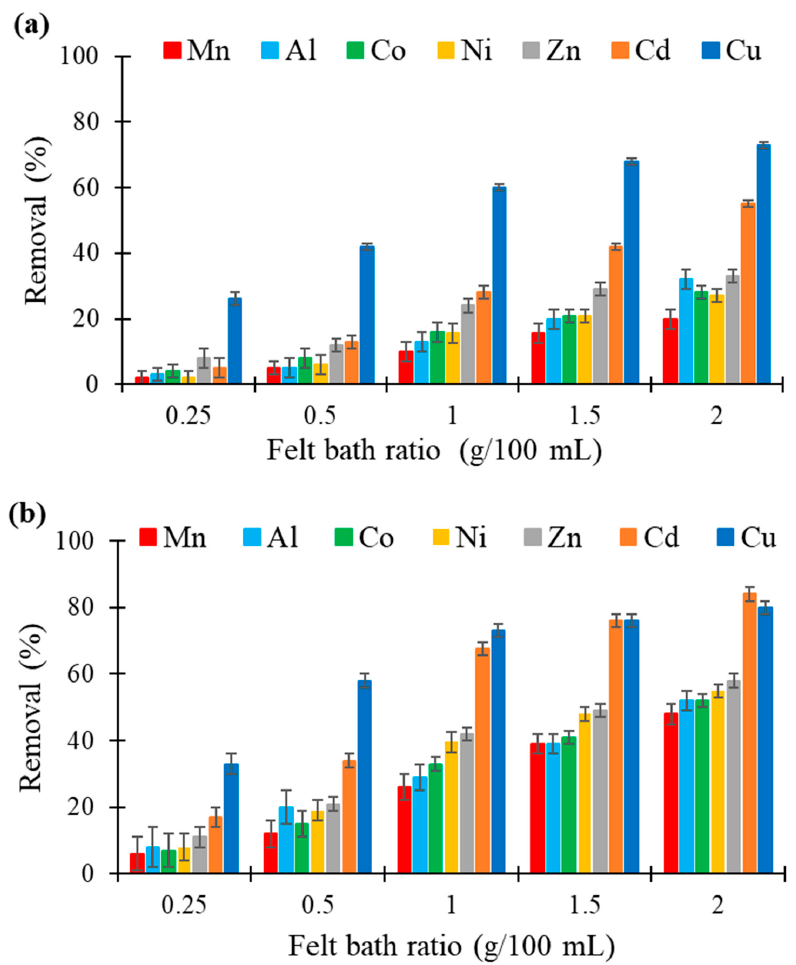
Figure 4. Comparison of the metal removal (in %) by different doses of ( a ) hemp- and ( b ) flax-based felts in 100 mL of mono-contaminated solutions with an initial metal concentration of 25 mg/L (other conditions: contact time, 60 min; agitation speed, 250 rpm; temperature, 22 ± 1°C; n = 3).